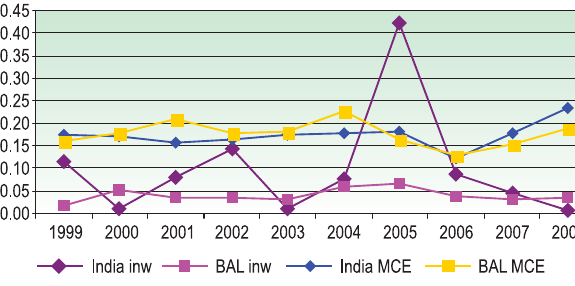
Fig. 7. FDI growth rates vs aggregated index MCE (the fi rst situation)